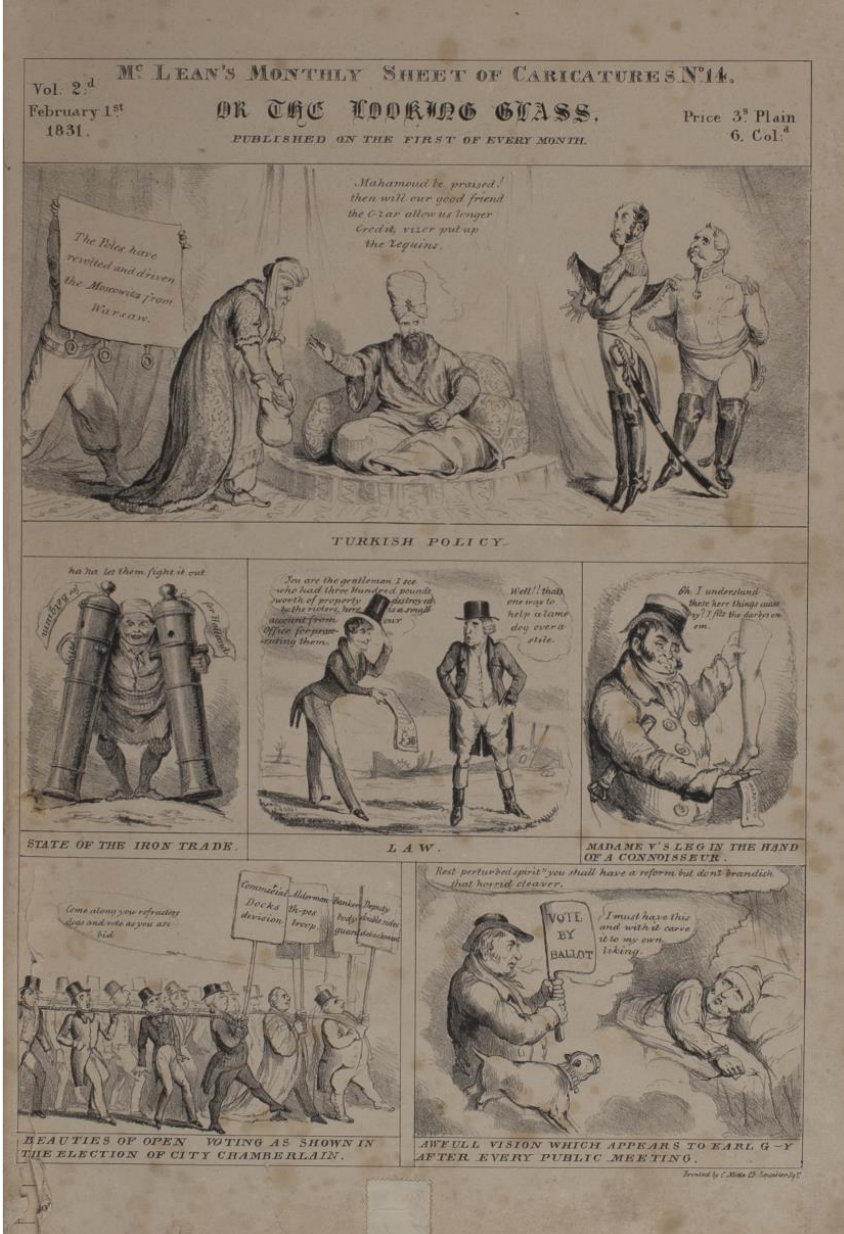
Lithographed page by Seymour from McLean’s Monthly Sheet of Caricatures, or The Looking Glass , 2.14 (1 February